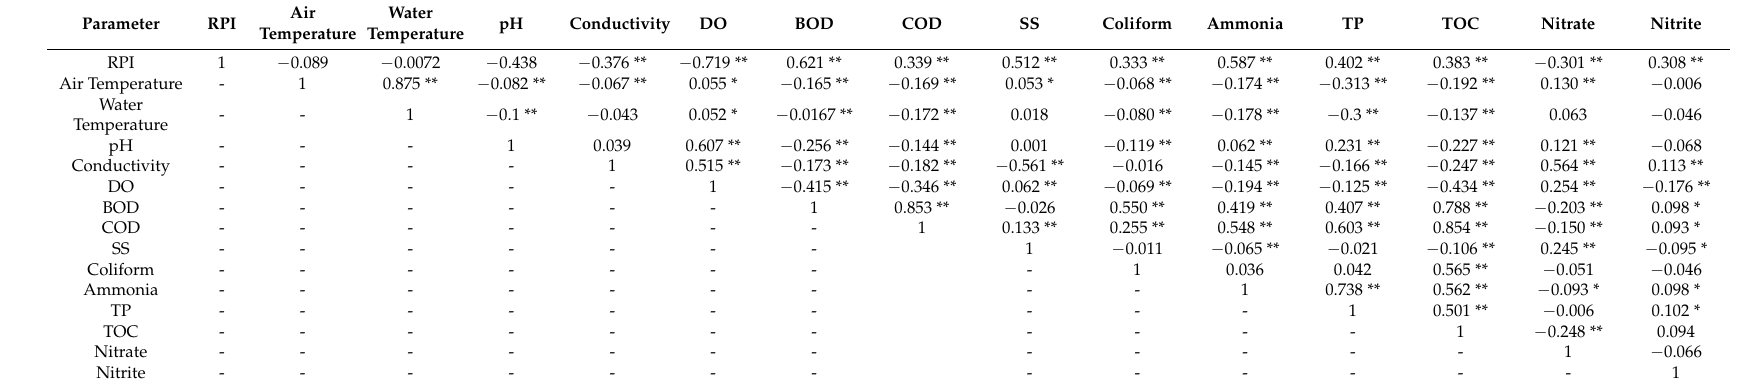
Table 3. Correlation matrix between RPI and other water quality data in the Erren